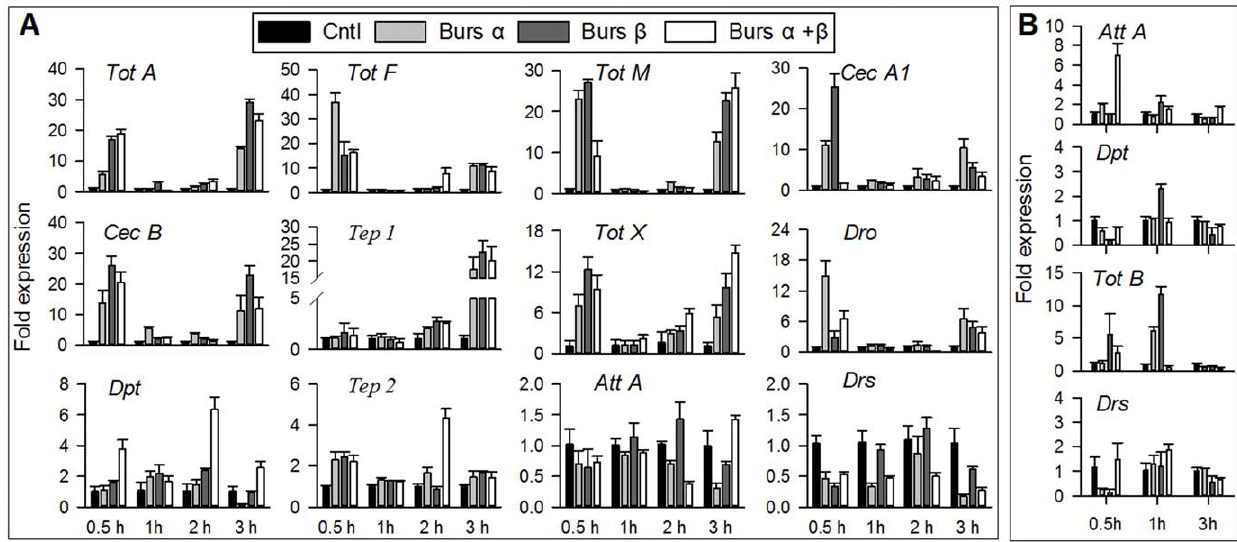
Figure 5. AMP transcript levels in rk 4 mutant. Newly emerged adult flies were neck-ligated immediately after emergence and at 1 h post- ligation injected with r-burs a 2 b heterodimer, burs a 2 a homodimer, burs b 2 b homodimer or blank vector transfected sample, as described in Figure 3. RNA was extracted for qPCR analysis of 11 representative genes (A). Larva FB from the mutant was also used to assay the effect of mutation on burs a 2 a and burs b 2 b homodimer induced AMP expression (B). The histograms show the means 6 SEM, n=3 biologically independent experiments.